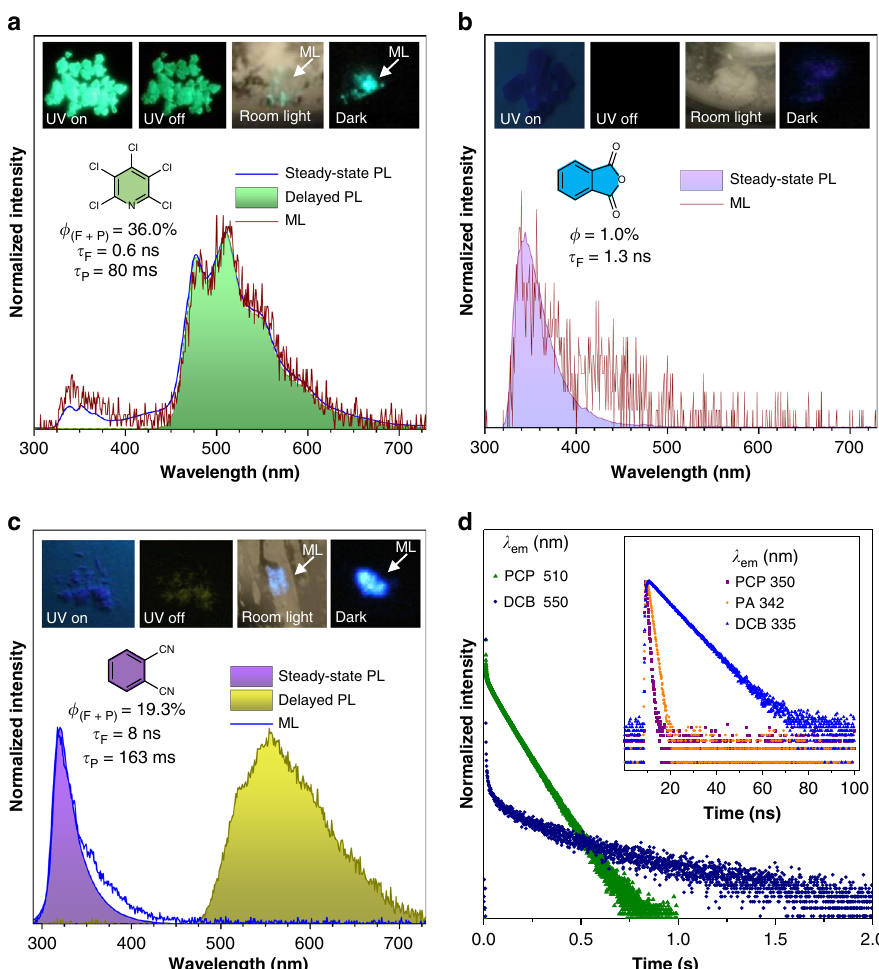
Fig. 2 Luminescent properties of the host molecules. a Steady-state photoluminescence (PL) spectrum, delayed PL spectrum ( λ ex = 254 nm) and mechanoluminescence (ML) spectrum of PCP crystals at ambient conditions. Insert: photos of PCP crystals under 254 nm UV light irradiation and after the UV irradiation ceased under ambient conditions (left); photos of ML produced by crushing PCP crystals on the wall of a glass vial under soft room lighting and in the dark respectively (right). b Steady-state PL spectrum ( λ ex = 254 nm) and ML spectrum of PA crystals at ambient conditions. Insert: photos of PA crystals under 254 nm UV light irradiation and after the UV irradiation ceased (left); photos of PA crystals being crushed on the wall of a glass vial under soft room lighting and in the dark respectively (right). c Steady-state PL spectrum, delayed PL spectrum ( λ ex = 254 nm) and ML spectrum of DCB crystals at ambient conditions. Insert: photos of DCB crystals under 254 nm UV light irradiation and after the UV irradiation ceased (left); photos of ML produced by crushing DCB crystals on the wall of a glass vial under soft room lighting and in the dark respectively (right). For delayed spectra in (a) and (c), delay time ( Δ t) = 50 ms. d Time-resolved PL decay curves of PCP crystals at 510 nm and DCB crystals at 550 nm ( λ ex = 254 nm). Insert: time-resolved PL decay curves of PCP crystals at 350 nm, PA crystals at 342 nm and DCB crystals at 335 nm ( λ ex = 280 nm). ϕ (F + P) : overall quantum yield; τ F : fl